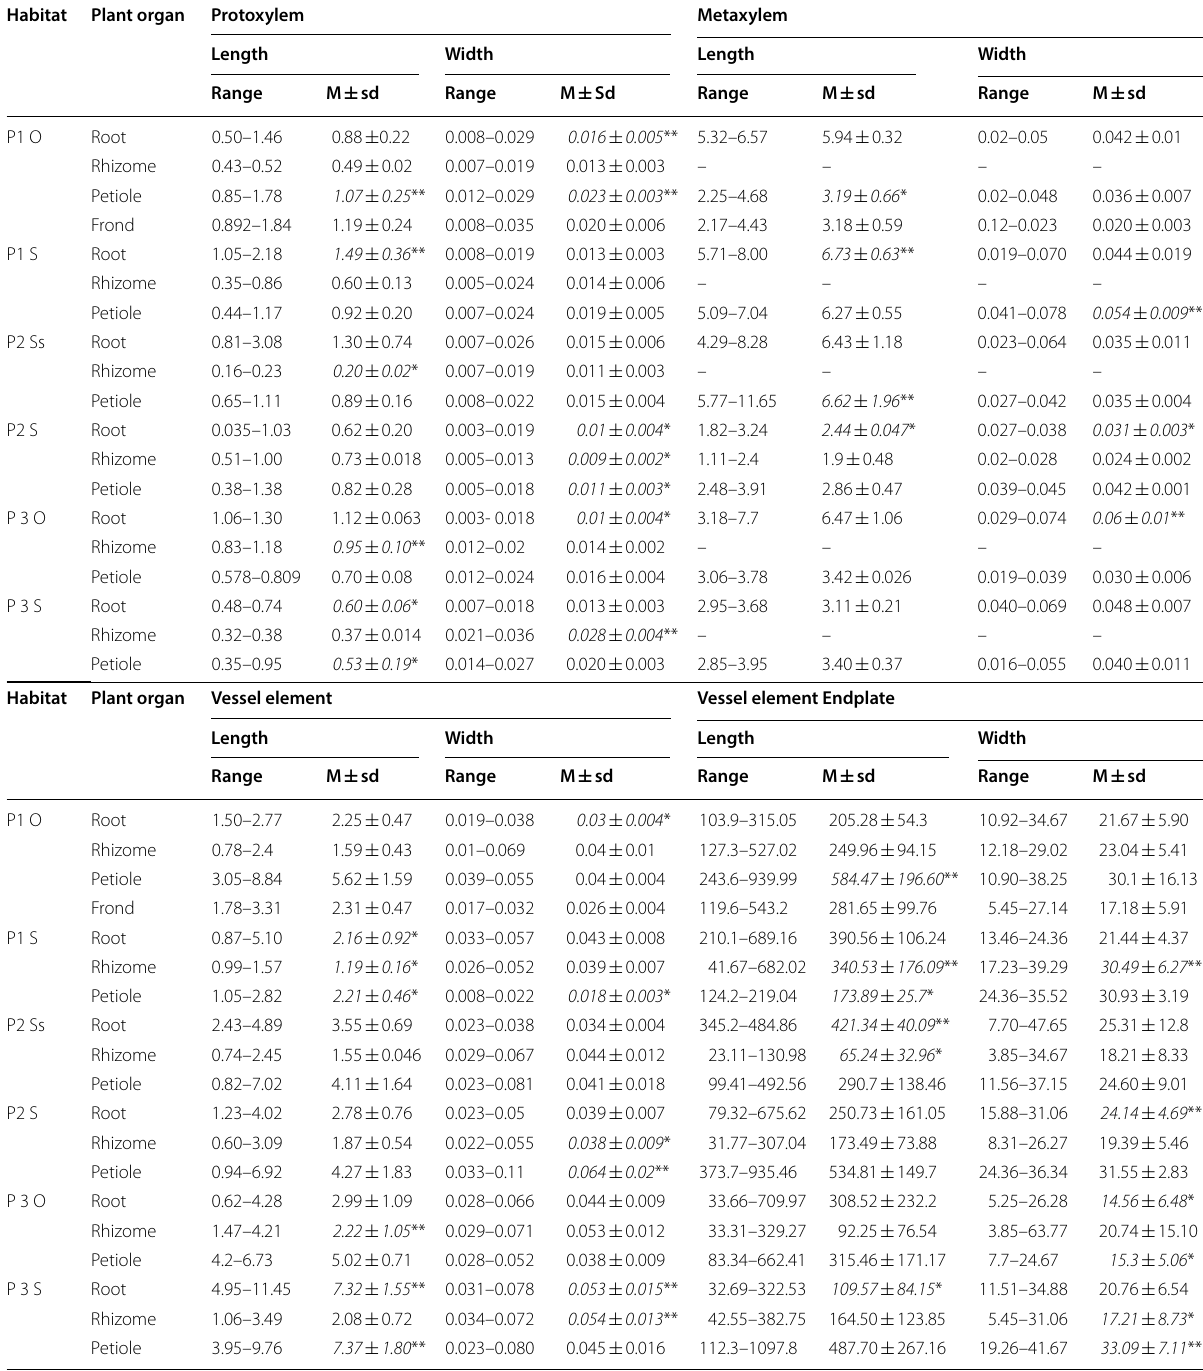
Table 2 Tracheary elements and vessel member end wall length–width(s) of Ampelopteris prolifera from